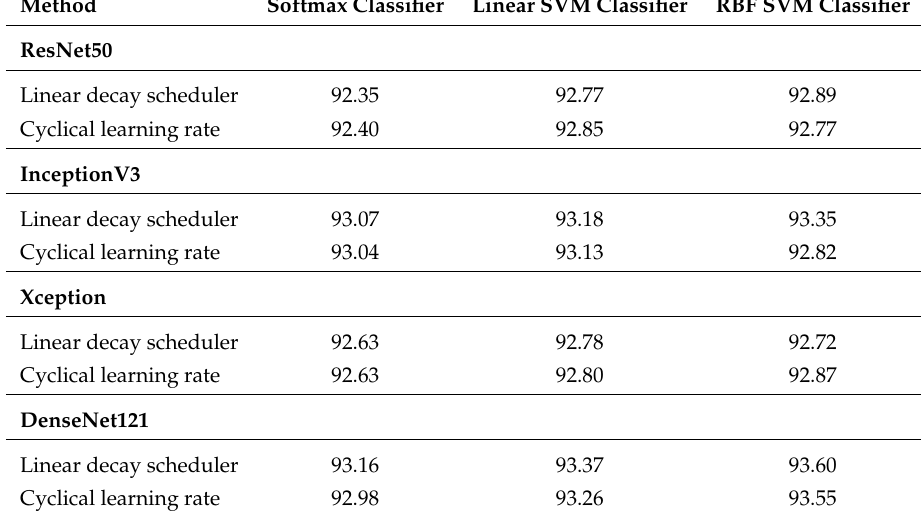
Table 4. Overall accuracy (%) of the proposed method with 20%/80% train/test ratio of NWPU-RESISC45 data set. The bold text highlights the best accuracy per